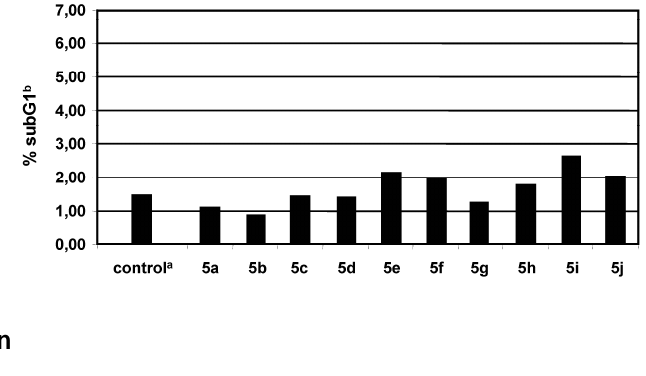
Figure 2. The pro-apoptotic effect of the newly synthesized compounds compared to pure solvent (compounds are considered pro-apoptotic over the rate of